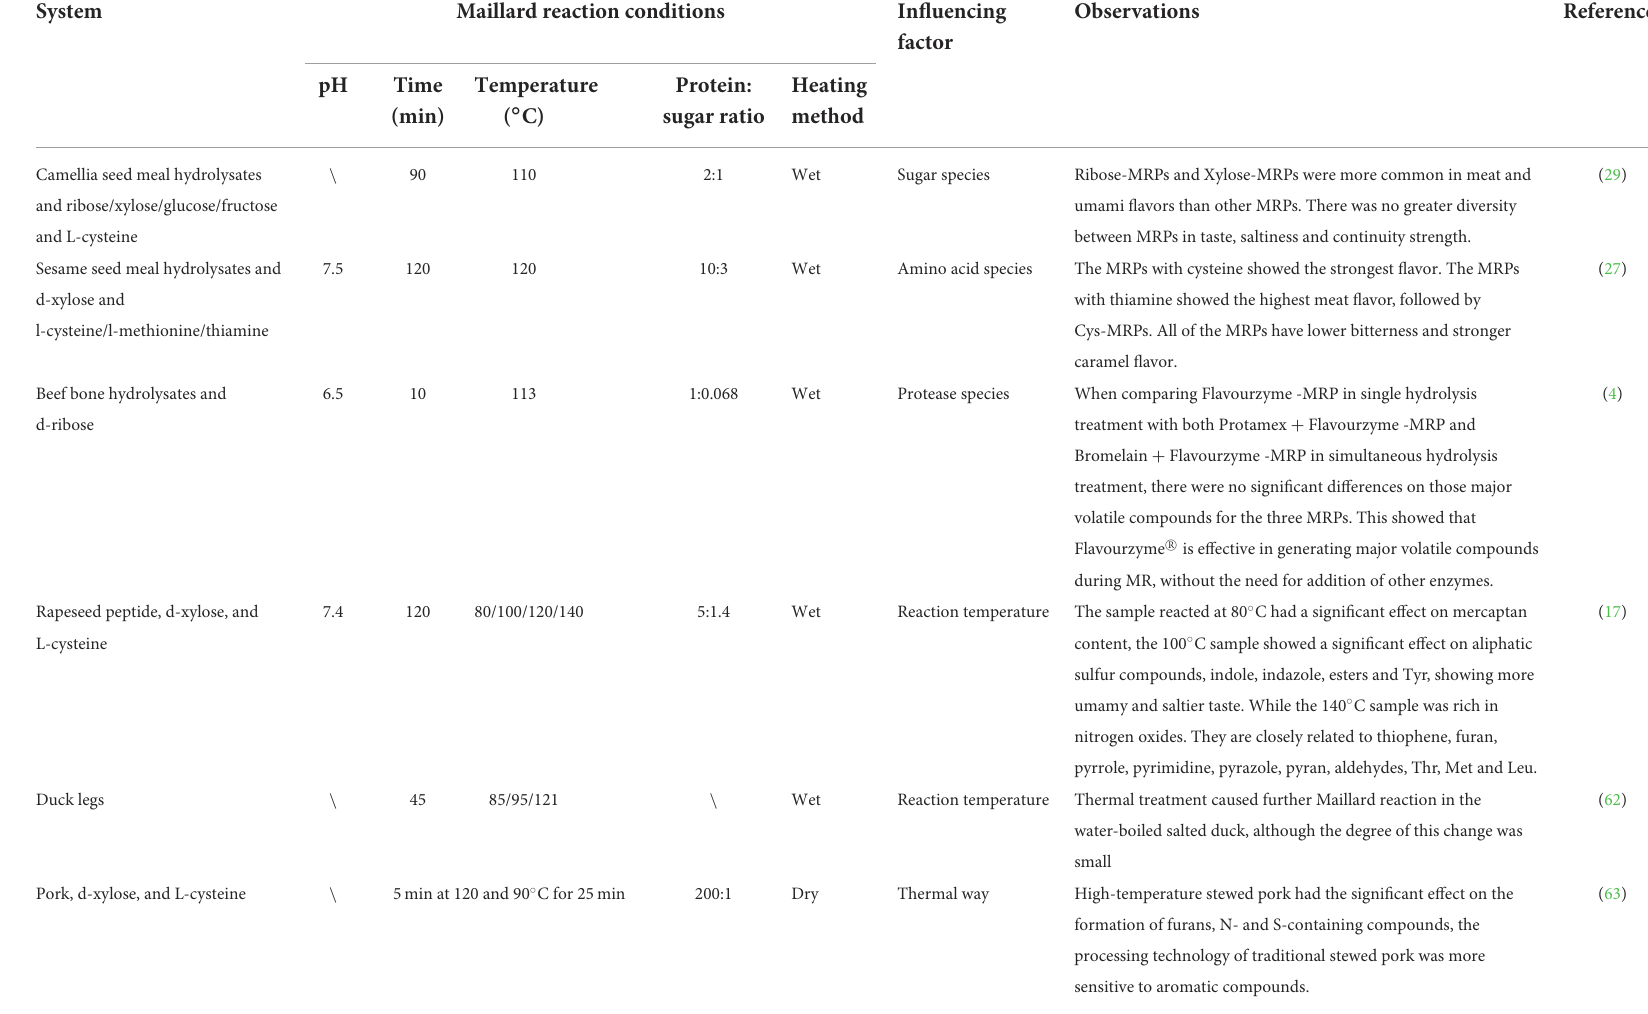
TABLE 3 The influence of different influencing factors of Maillard reaction products